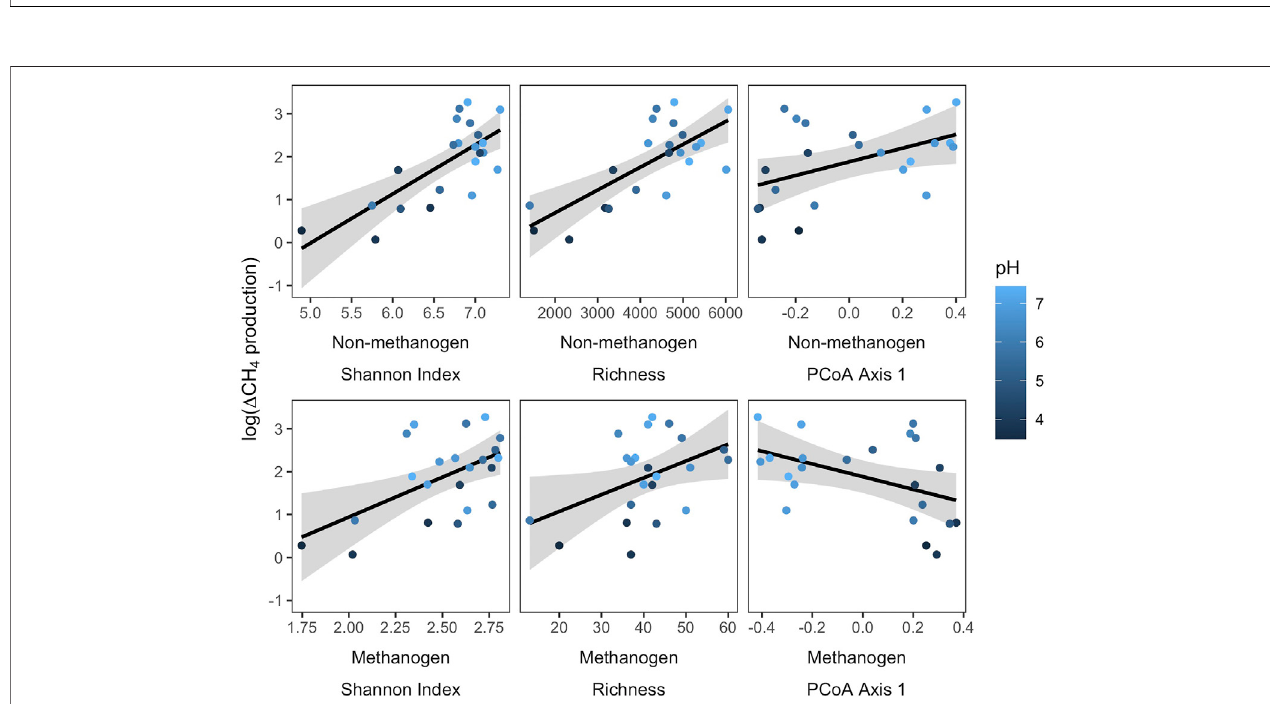
FIGURE 3 | Correlations between the log-transformed difference in net methane production amongst organic matter additions ( Δ CH 4 production) and metrics of microbial community composition. Statistics are reported in Table 2 .